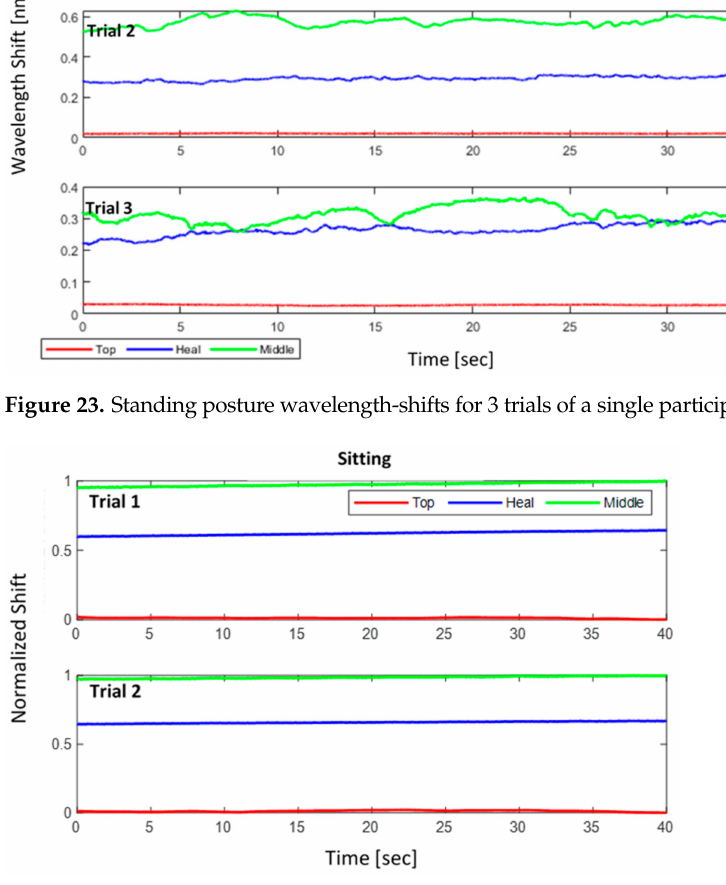
Figure 24. Sitting posture normalized shift for 2 trials of a single